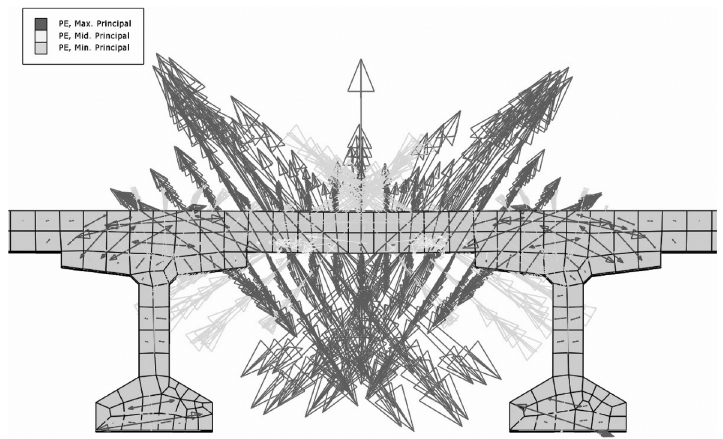
Fig. 22. Principal plastic strain direction, blast above, between girders.